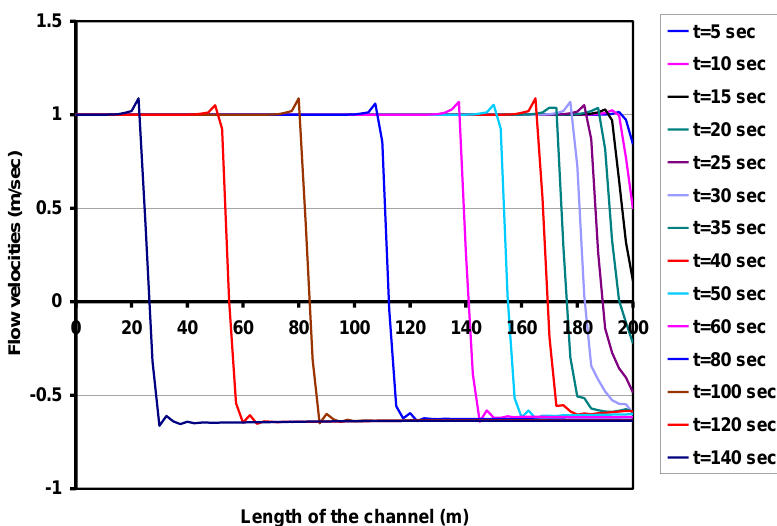
Figure 5. Flow velocities along the channel due to bore